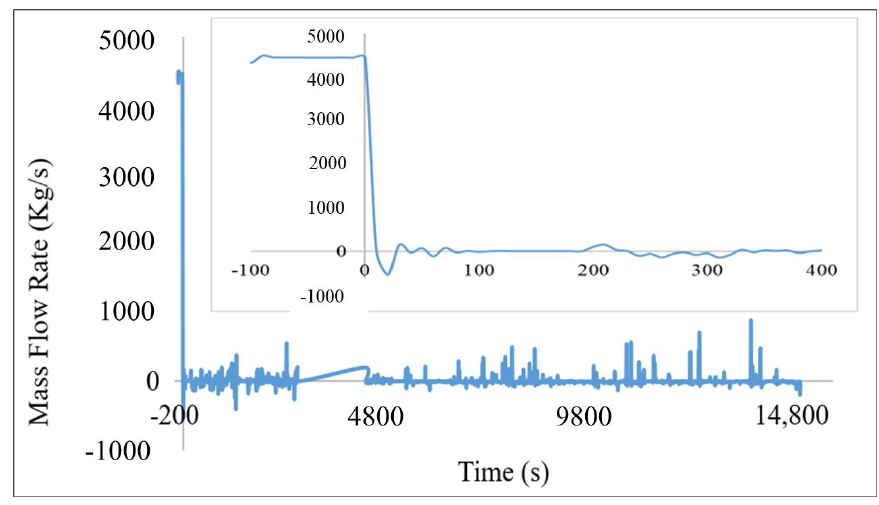
Figure 5. Flow rate of coolant at the core inlet. At the time of cold leg rupture, the outlet primary pressure increased, then it sharply dropped in less than 10 s, as shown in Figure 6. The broken cod leg depressurized faster than unbroken legs of RPV. The reactor primary pressure performance was similar in both analyses of RPV and PRZ.